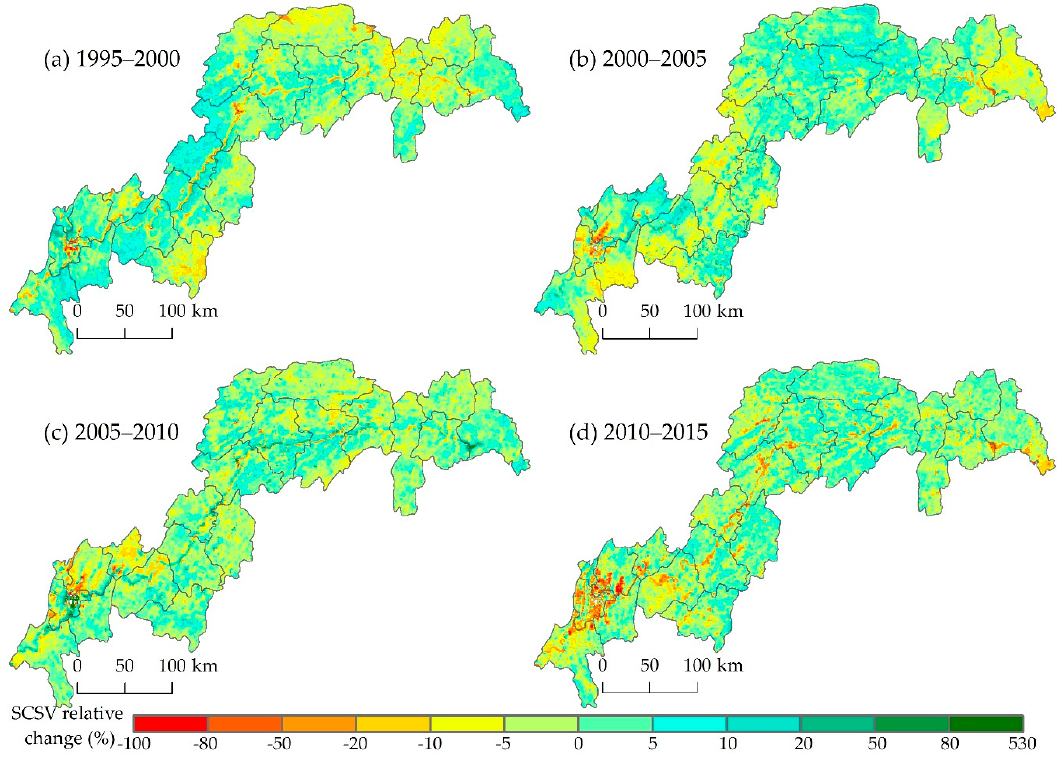
Figure 7. Changes of soil conservation service values in the Three Gorges Reservoir Area for ( a ) 1995–